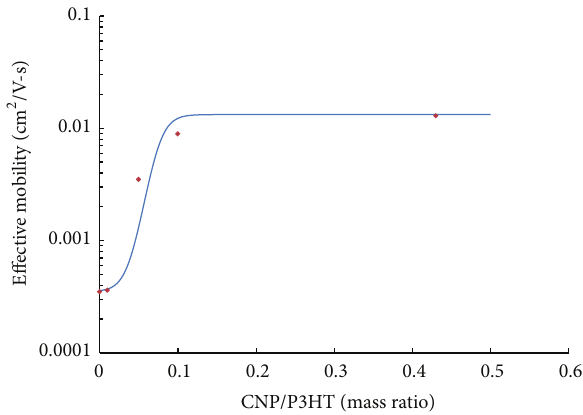
Figure 3: Percolation model for simulation and experimental